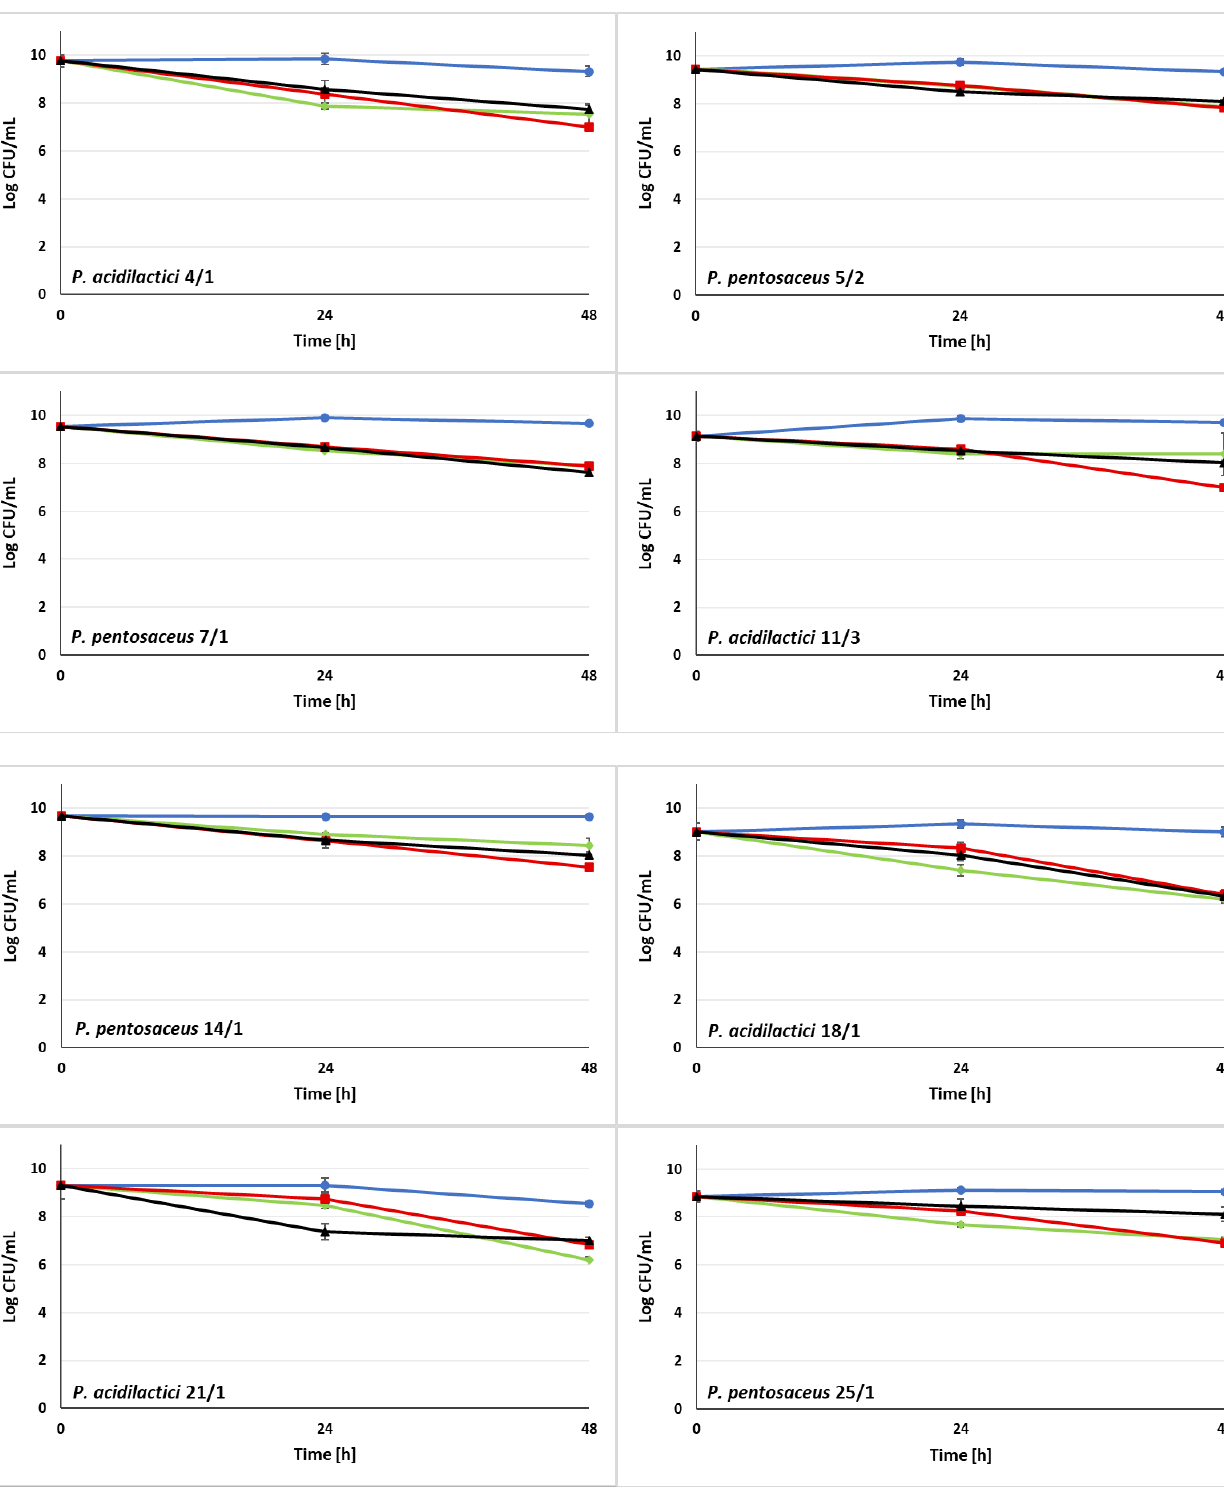
Figure 3. Survival of lactic acid bacteria (LAB) strains in sugar syrups A, B, and C after 24 and 48 h of incubation. The color of the line indicates the incubation conditions of LAB. Blue (circular mark- ers)—no sugar syrup (control); green (diamond markers)—syrup A (40% glucose, 30% fructose, pH 4.2, distilled water); red (square markers)—syrup B (30% glucose, 40% fructose, 30% saccharose, distilled water); and black (triangular markers)—syrup C (50% saccharose, distilled water). Results are presented as true mean ± standard deviation.